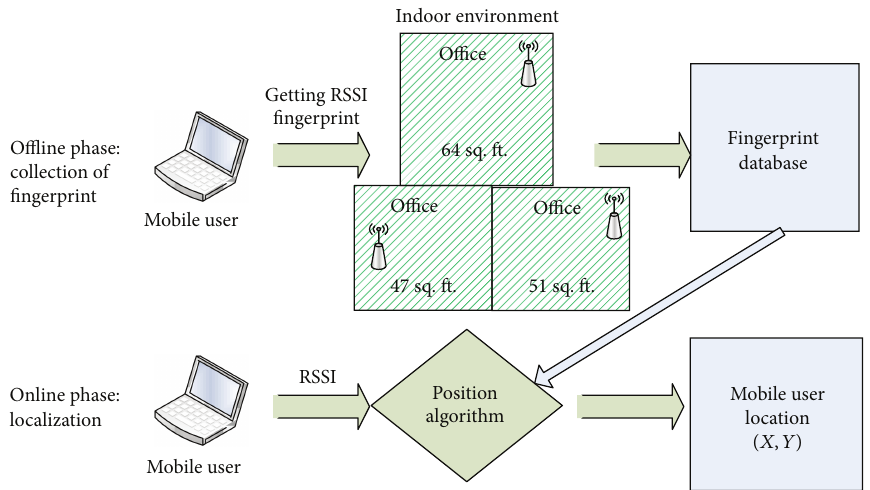
Figure 8: Fingerprinting based